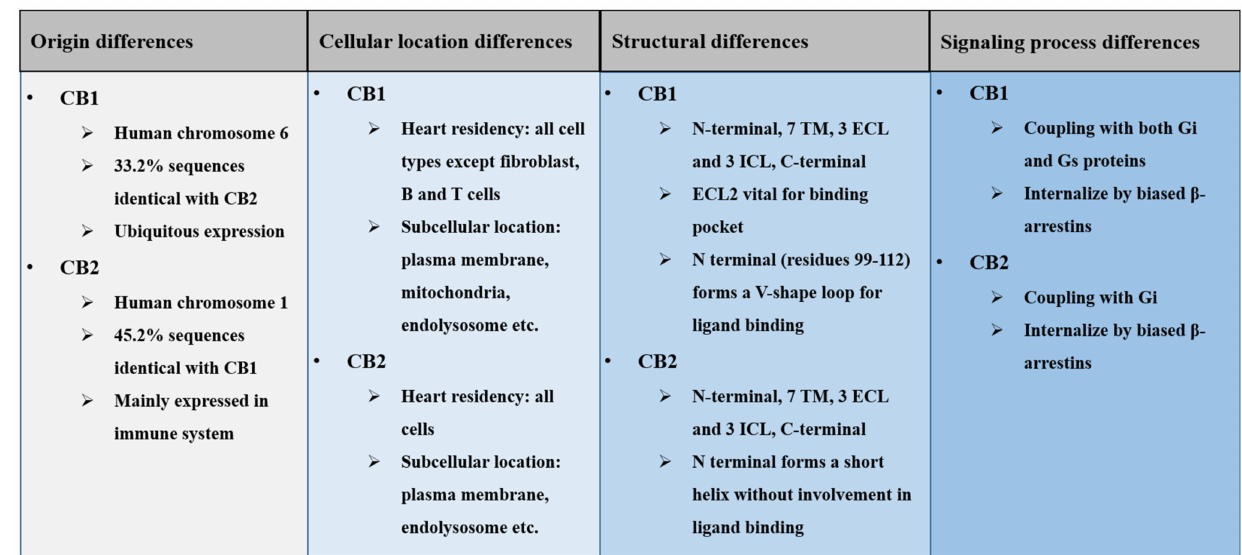
Figure 2. A summary of basic differences between the CB1 and CB2